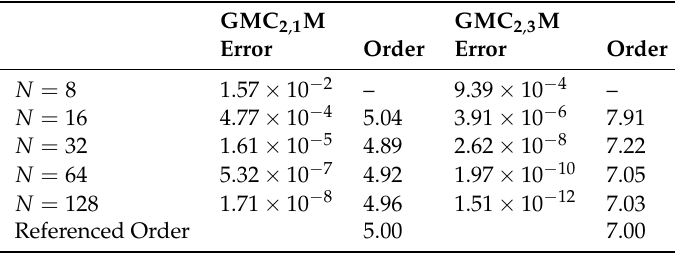
M for Example 1. 1 , k 2